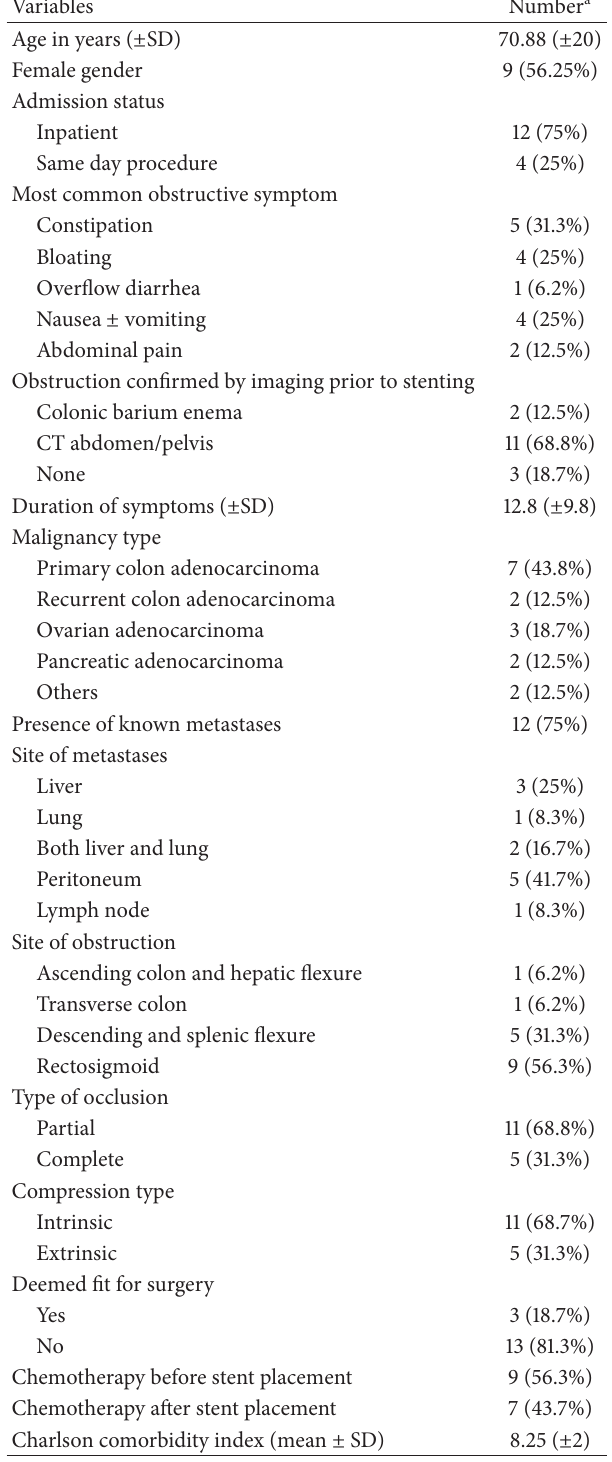
Table 1: Baseline patient characteristics (𝑁 = 16)